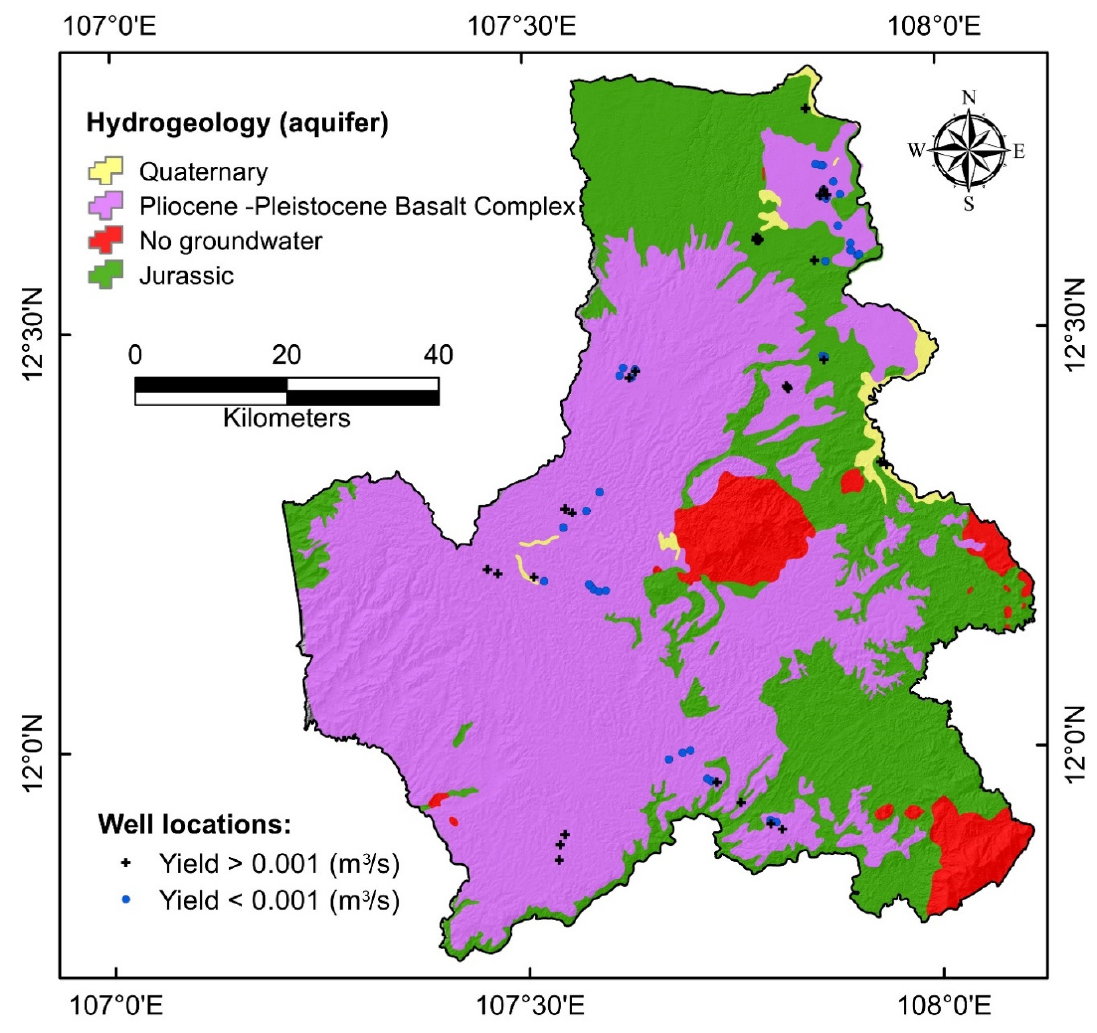
Figure 2. Hydrogeological map of the study area.